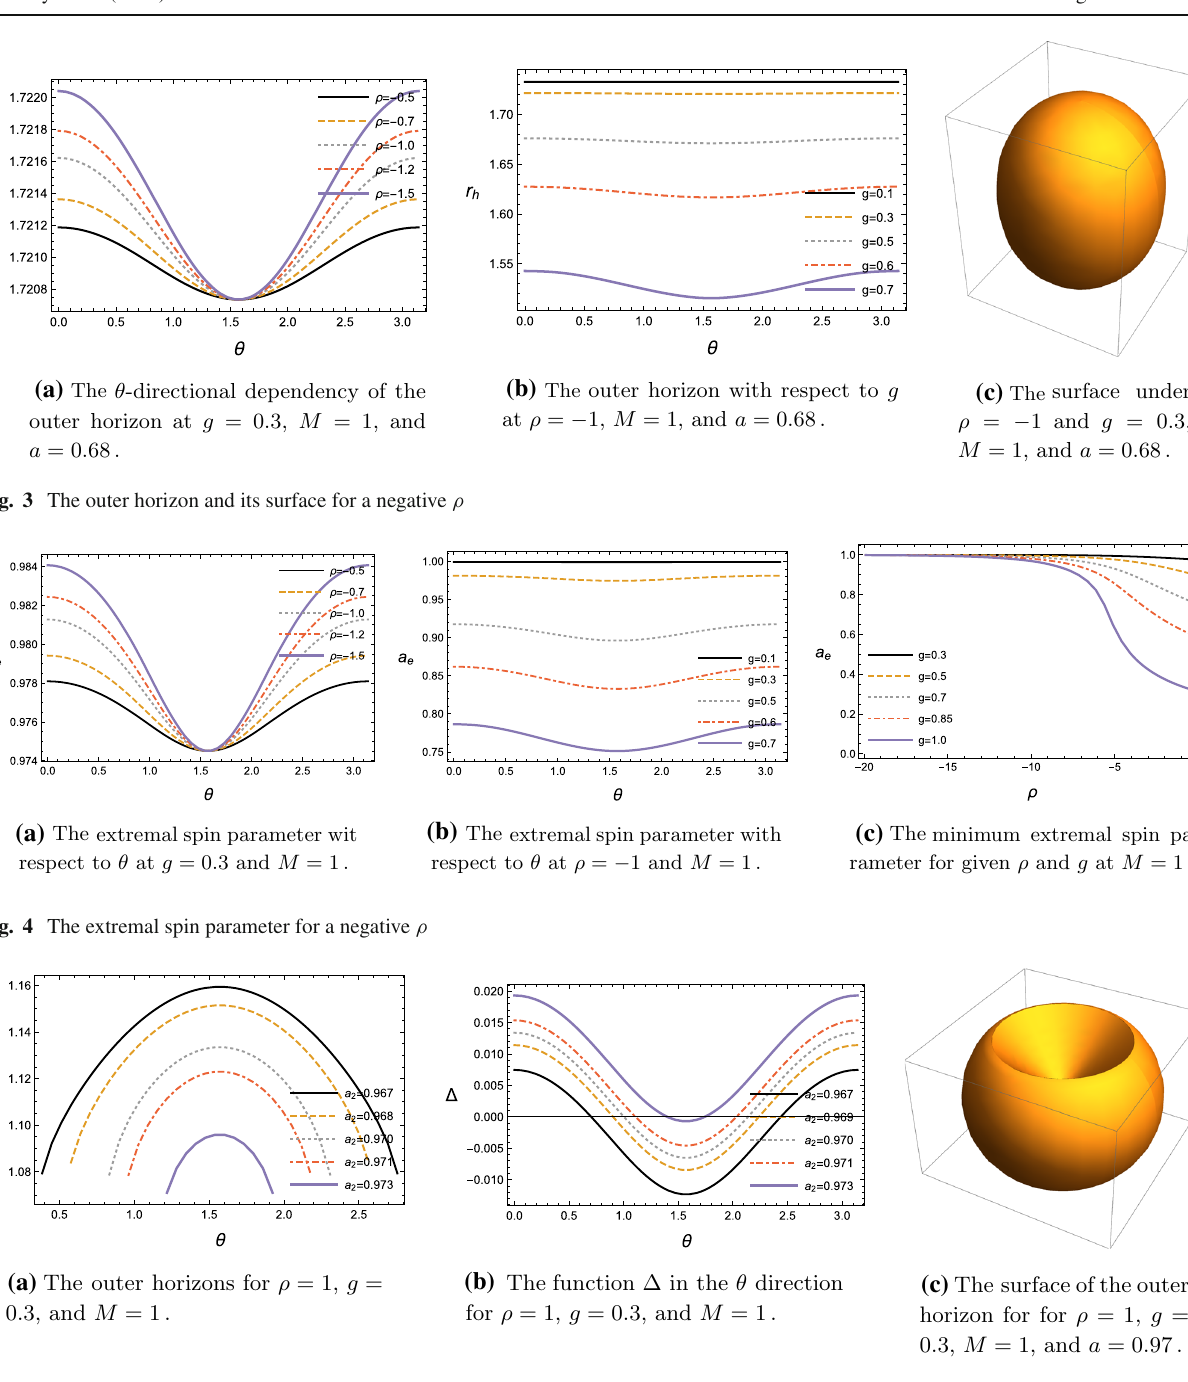
larity in our universe [72–74], because there is no singularity in its inside. The extremal spin parameter is the smallest at the pole of the black hole for positive ρ cases, so that the horizon first disappears at the pole in the radial direction. However, there are horizon-like surfaces at θ directions in Fig. 5b because the function of (cid:5) still has two sign changes in the θ direction. This means that even if the horizon